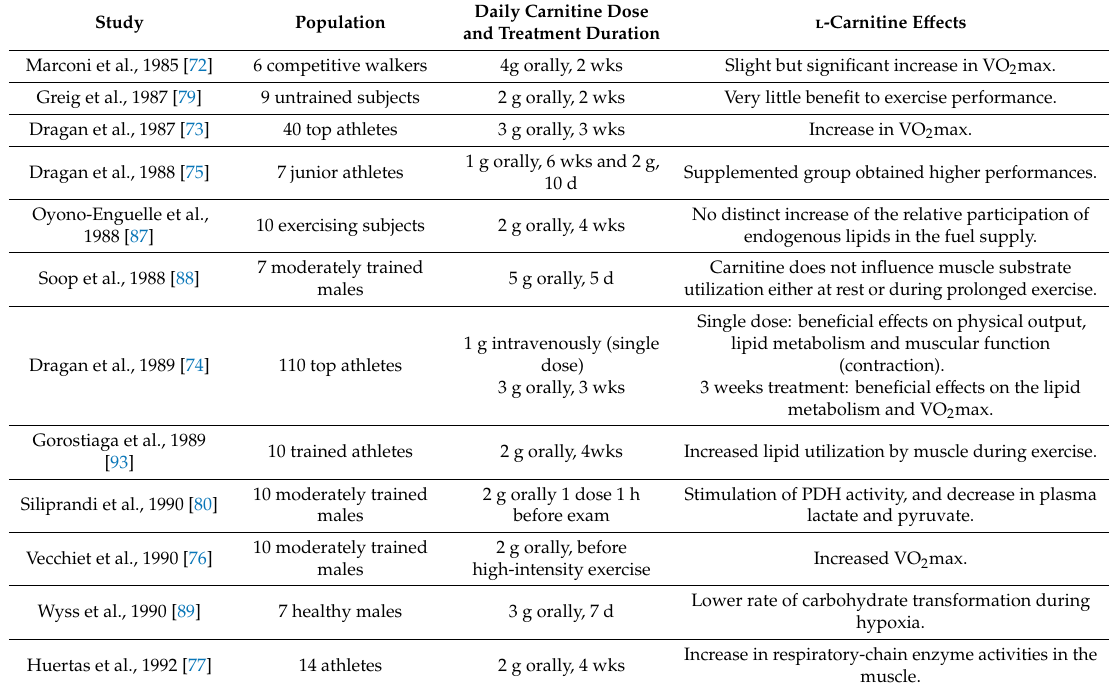
Table 1. E ff ect of carnitine supplementation on muscle energetics and exercise